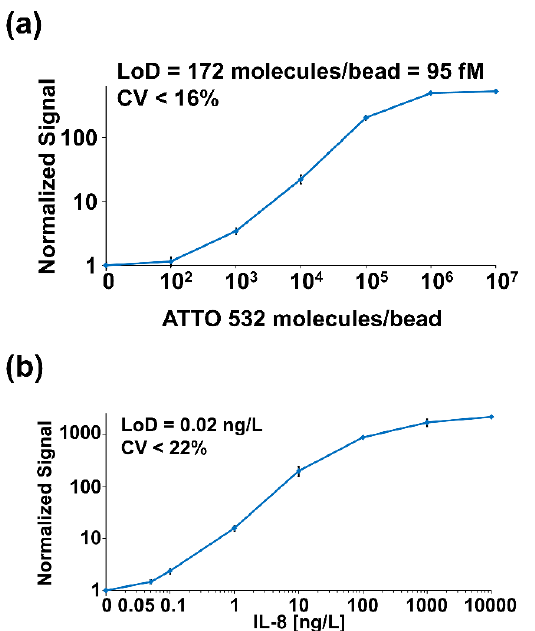
Figure 16. Dose-response experiments with the OMB system. ( a ) ATTO 532 dose-response with streptavidin-coupled M280 magnetic beads. The calculated limit of detection (LoD) is 95 fM, and the coefficient of variation (CV) is less than 16%. ( b ) Recombinant human interleukin 8 (IL-8) dose-response in buffer. The calculated LoD is 0.02 ng/L. From [62] with permission.